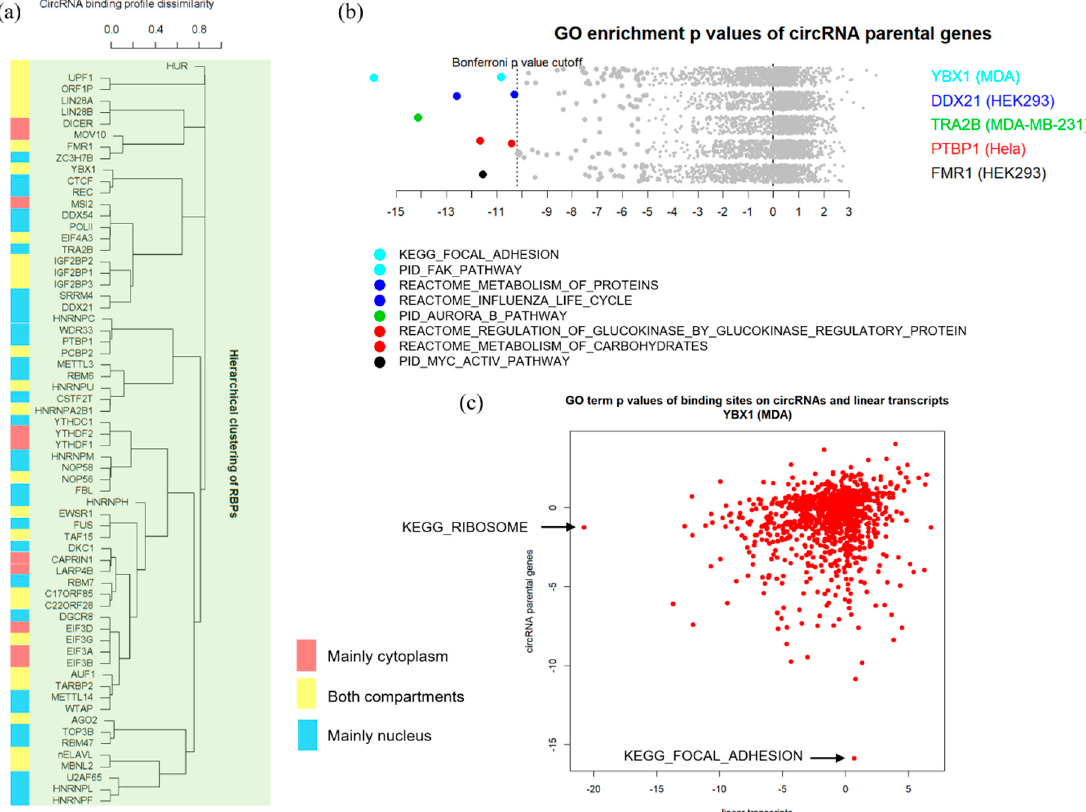
Figure 5. Functional implications of RBP-circRNA interactions. ( a ) Hierarchical clustering plot of RPBs based on the similarity of their circRNA binding profile. This analysis is only conducted for the human RBPs. Red marks RBPs that are mainly cytoplasmic, yellow marks RBPs that abundantly exist in both cytoplasm and nucleus, and blue marks RBPs that are mainly nuclear. ( b ) Enriched gene ontology (GO) terms for each RBP. Log-transformed p -value is calculated as p -value from a hypergeometric test of each set of parental genes of circRNAs bound by an RBP vs. genes in each gene ontology term, subtracted by averaged random p -value from hypergeometric tests of 10 randomizations. The significance level is controlled at 0.05, adjusted by the Bonferroni method. Significantly enriched GO terms are labeled according to the colors of the RBPs. ( c ) Log-transformed GO terms enrichment p -values of binding sites in circRNA parental genes vs. in linear transcripts for the YBX1 protein. The adjustment method is the same.